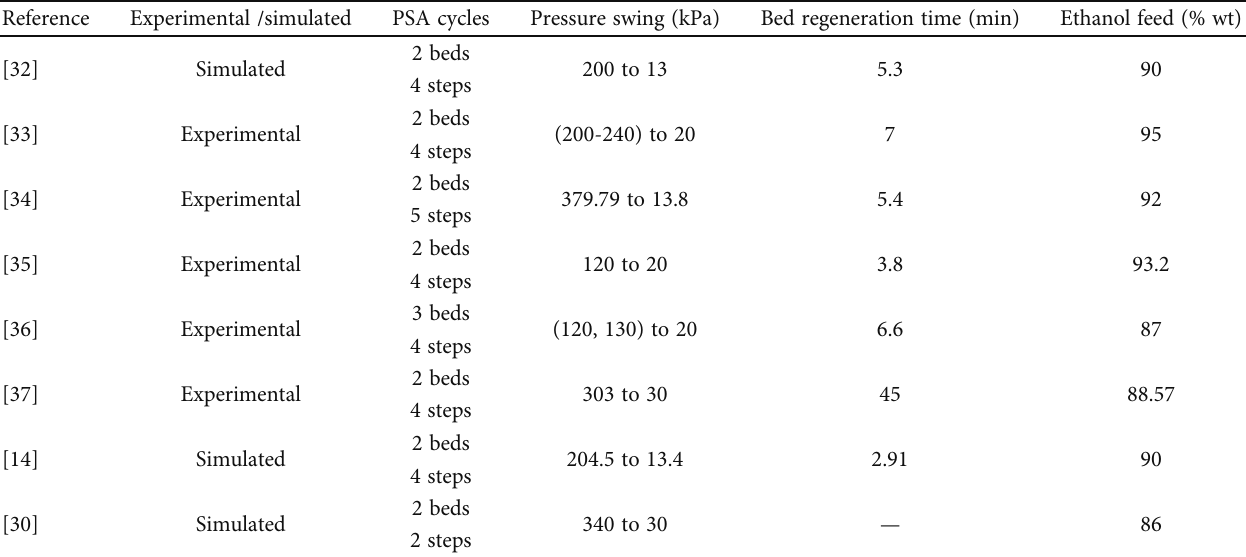
Table 3: Works reported on the di ff erent con fi gurations of PSA processes for puri fi cation of